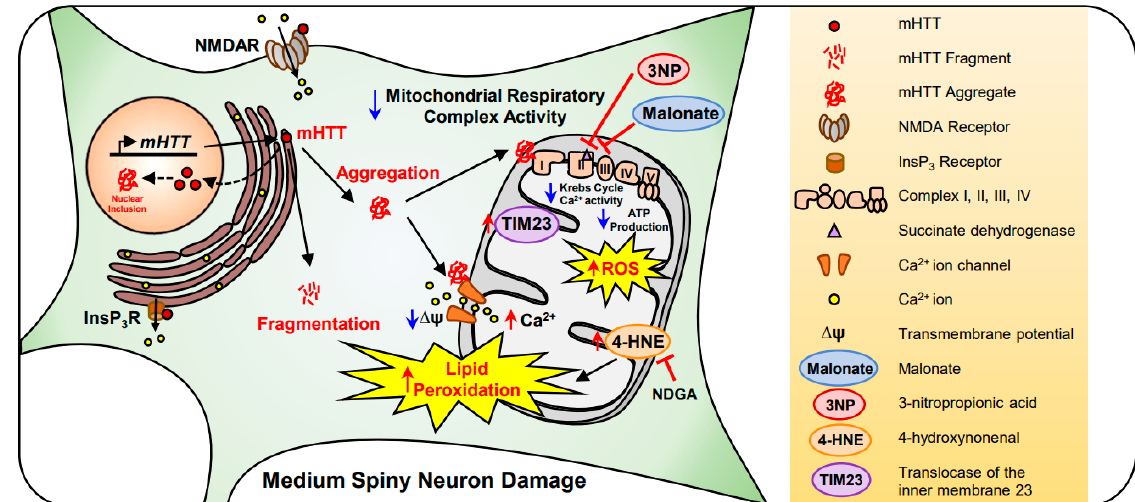
Figure 3. Mitochondrial dysfunction and lipid peroxidation are found in the medium spiny neuron (MSN) of HD. mutant Huntingtin ( mHTT) gene expresses mHTT protein in the MSN. mHTT inclusions are increased in the nucleus and cytosol. In the cytoplasm, both increased mHTT protein fragments and aggregates triggers neuronal damage. The aggregated form of mHTT decreases Krebs cycle and Ca 2+ activity, resulting in a decrease in complex I–IV or mitochondrial respiratory complex activity. mHTT aggregation also decreases mitochondrial membrane potential ( ΔΨ ) and increases reactive oxygen species (ROS) production. As Ca 2+ permeability increases, the mitochondrial membrane is hyperpolarized, triggering cell loss. In chemical models of Huntington’s disease (HD), malonate and 3-nitropropionic acid (3NP) inhibits succinate dehydrogenase (SDH) at complex II and, eventually, reduces ATP production via complex V. Lastly, the level of 4-hydroxynonenal (4-HNE), a neuronal lipid peroxidative damage marker, is elevated in HD and nordihydroguaiaretic acid (NDGA) reduces 4-HNE levels and prevents mitochondrial damage in the MSN.